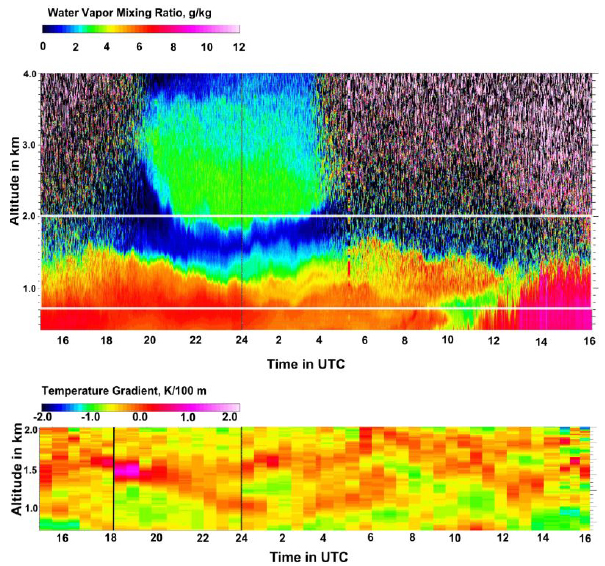
Figure 13. Time series of the water vapor mixing ratio (upper panel) and temperature gradient (lower panel) measured between 15:00UTC on 18 May 2013 and 16:00UTC on 19 May 2013. The white lines in the lower panel mark the height range of the data in the upper panel.